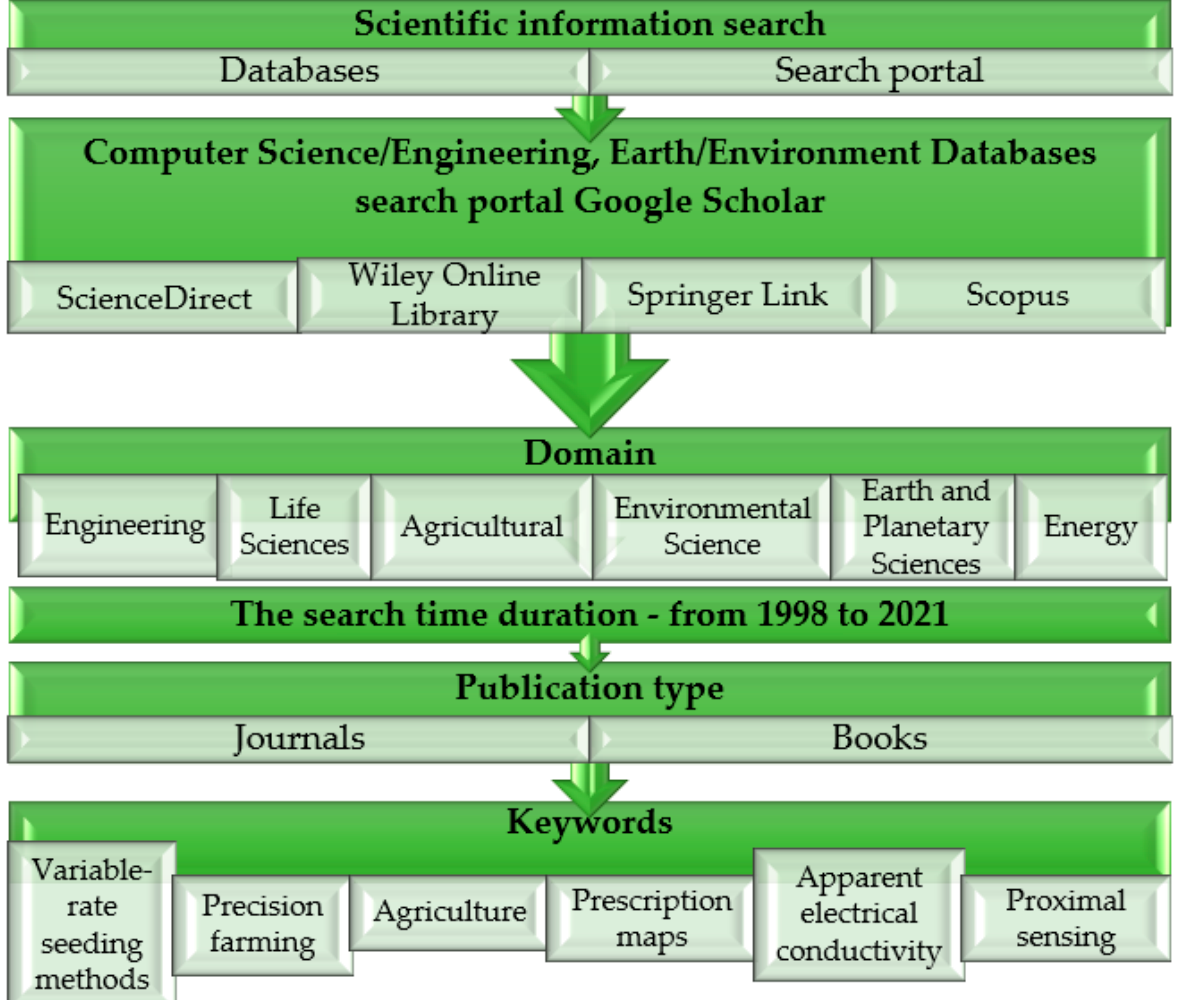
Figure 1. Scientific review information search strategy and enforcement selection